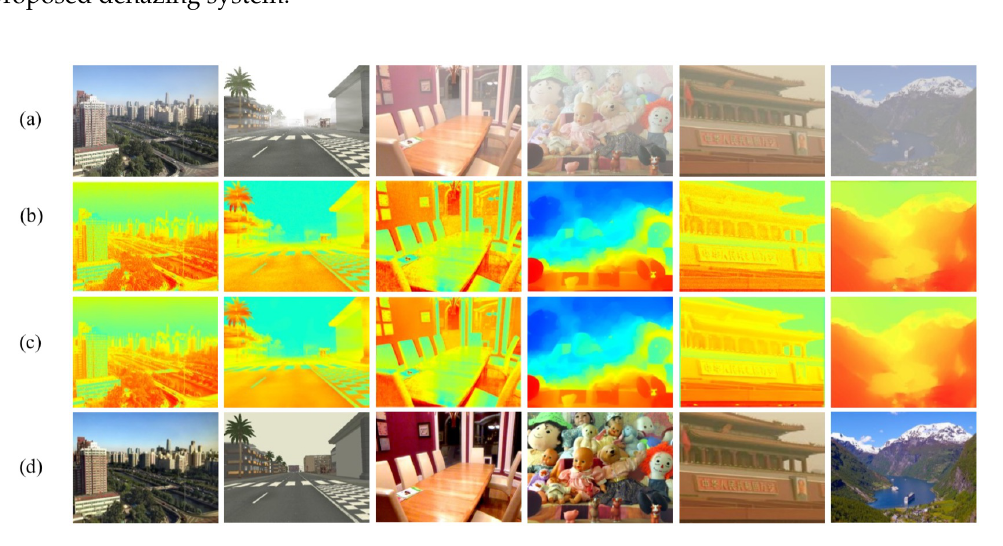
Figure 12. Visual results of proposed model: ( a ) hazy images; ( b ) rough transmission map t r ; ( c ) refined transmission map t ; and ( d ) dehazed